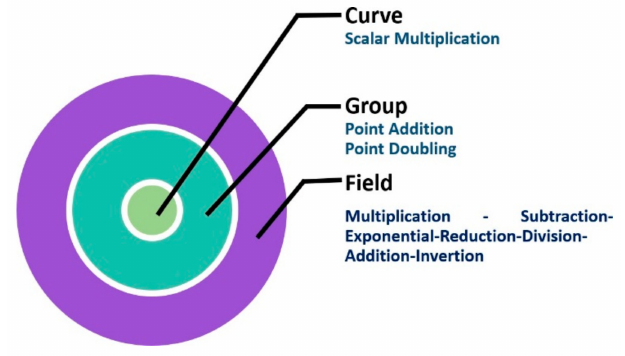
Figure 3. Illustration of elliptic curve cryptography